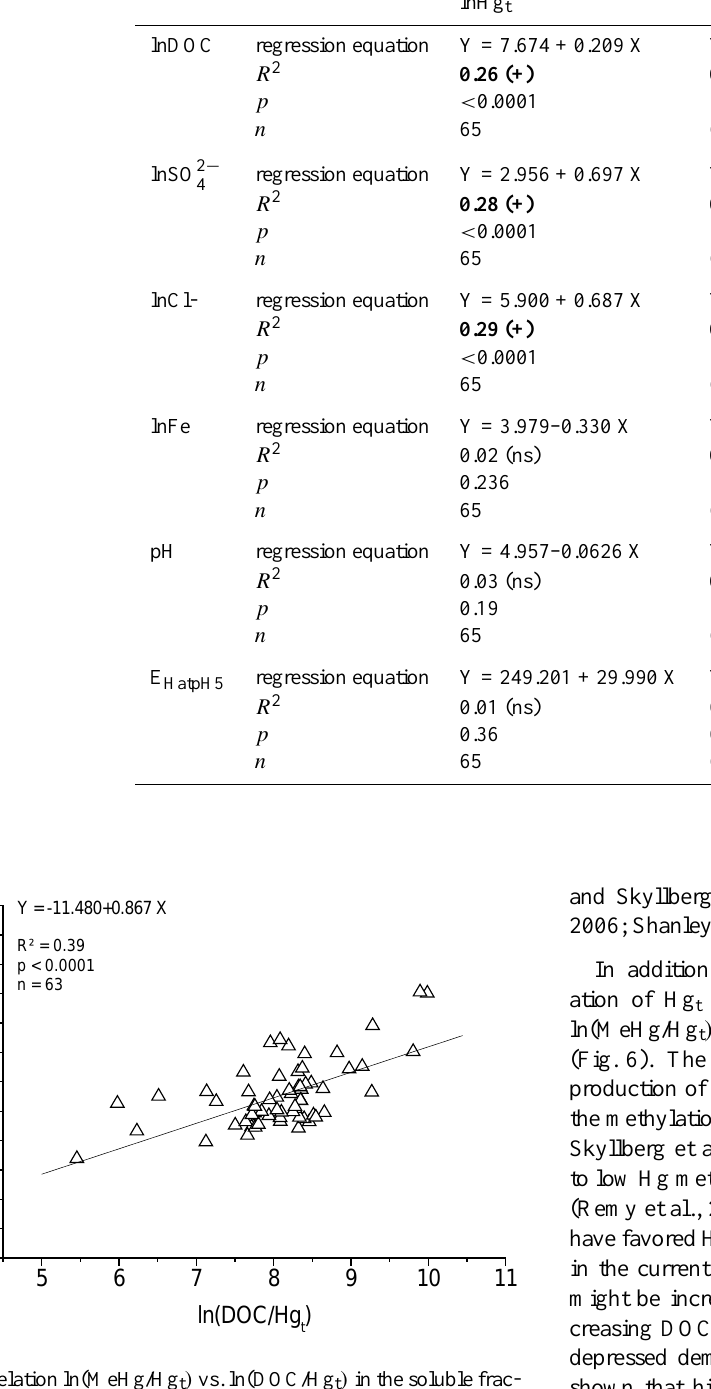
) , DOC, E HatpH5 , Fe, and pH in the 4